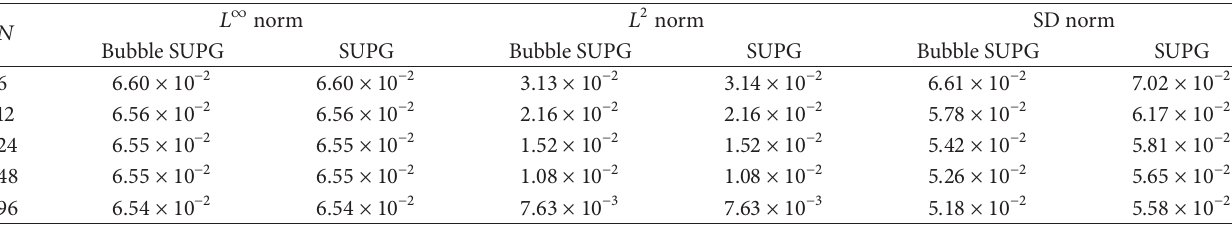
Table 18: 𝜀 = 10 −8 , Problem 2 (comparison of global